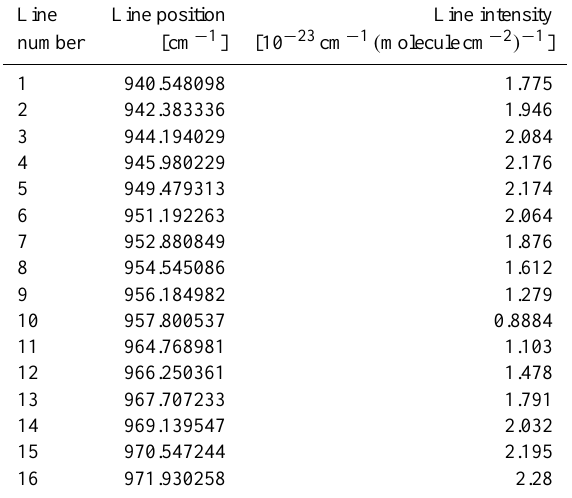
Table 1, the apparent line position is evaluated for each